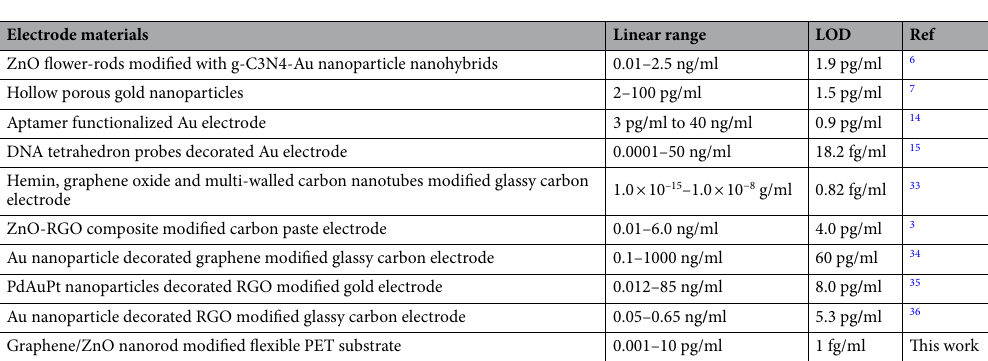
Table 1. A comparison of some previous biosensors and present biosensor for CEA detection.